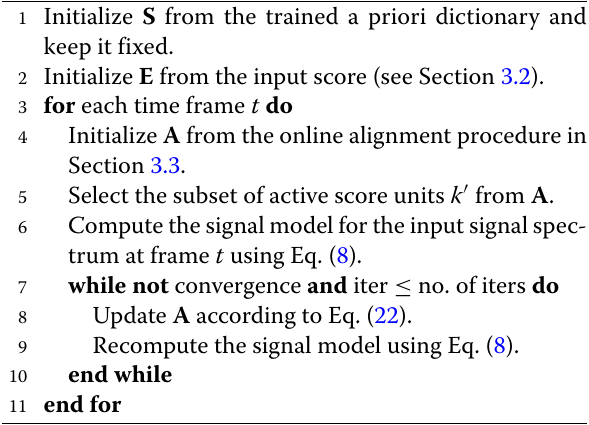
Algorithm 2 Online signal factorization